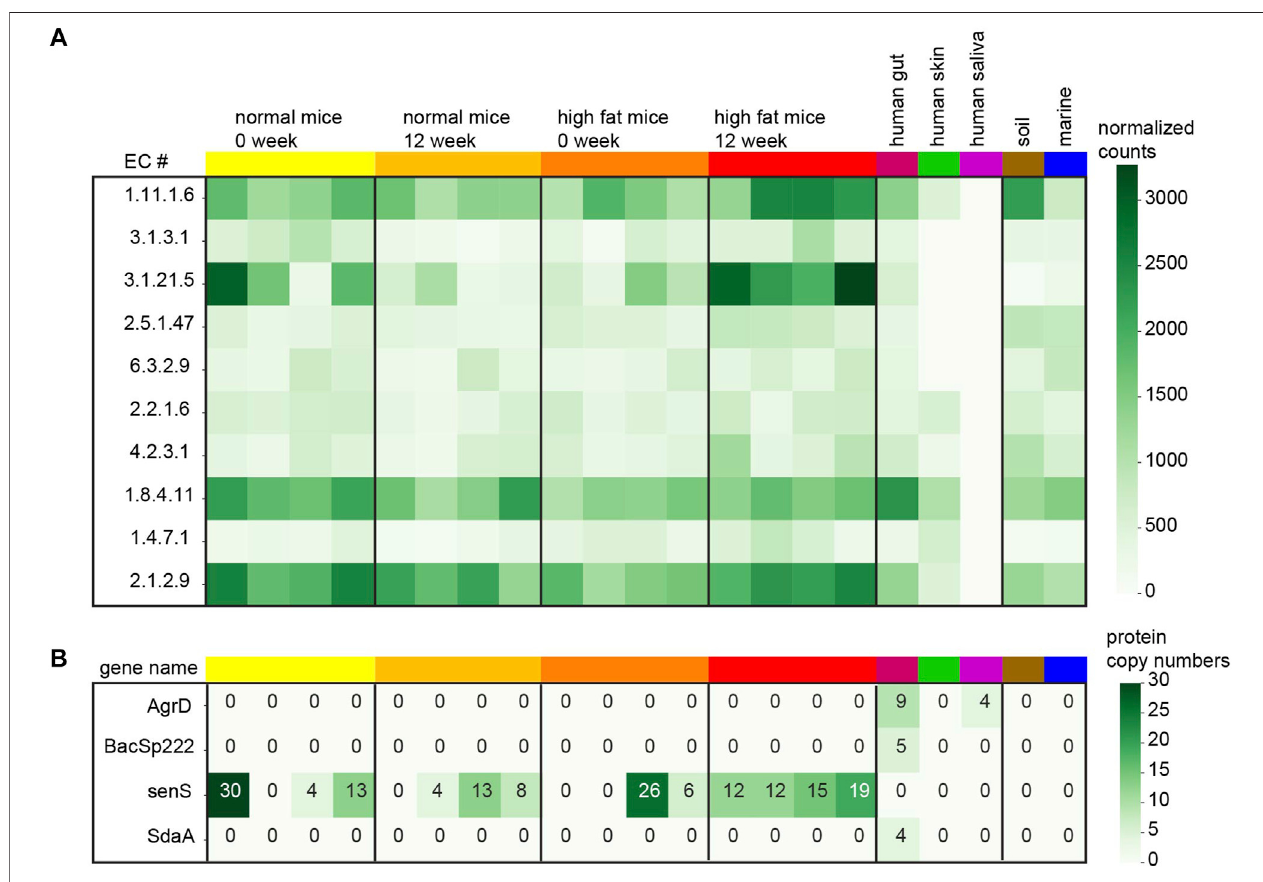
FIGURE2| Small protein quanti fi cation ineach sample. (A) Normalized counts (smallproteins per million) fortop tenEC numbers comparing thehigh-fat dietmice with the normal mice after 12 weeks. (B) Protein copy numbers for 4 known small genes recovered from the samples.